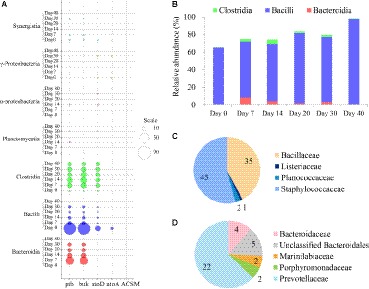
Temporal distribution of butyrate producers in the fermented grains of Luzhou-flavor baijiu. (A) Taxonomic distribution and enzymes (ptb, buk, atoD, atoA and ACSM) reads for butyrate formation in the microbial community of fermented grains via PICRUSt analysis. The diameters of bubbles (scale) are proportional to the read numbers of enzymes. (B) Succession of three major classes (Clostridia, Bacilli, and Bacteroidia) related to butyrate synthesis based on sequencing of 16S rRNA gene. (C) Family-level diversity of buk-associated Bacilli in the fermented grains on day 0. The numbers represent the read numbers of buk. (D) Family-level diversity of buk-associated Bacteroidia in the fermented grains on day 7. The numbers represent the read numbers of buk.